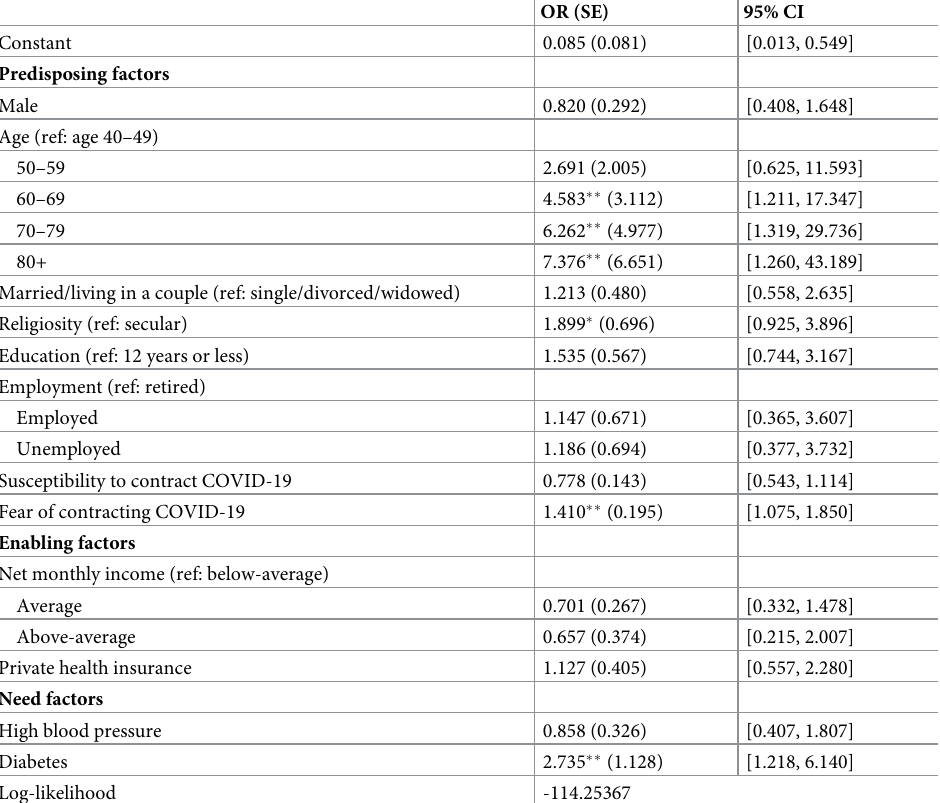
Table 4. Logistic regression model for forgone care (n = 188) a